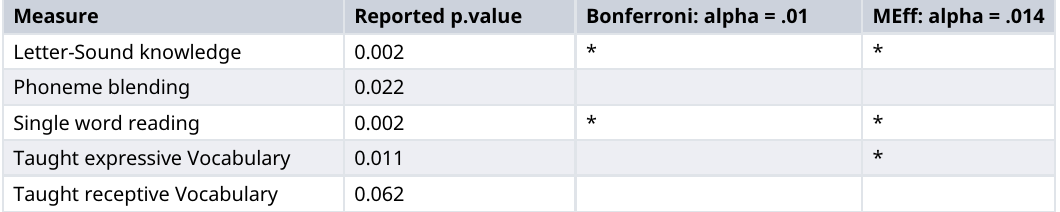
Table4.P-valuesfromBurgoyne etal. (2012).